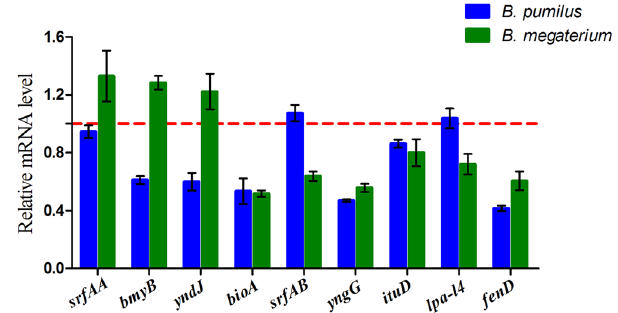
Figure 9. The effects of the organic acids on the transcription of biocontrol genes in bacteria evaluated by qRT-